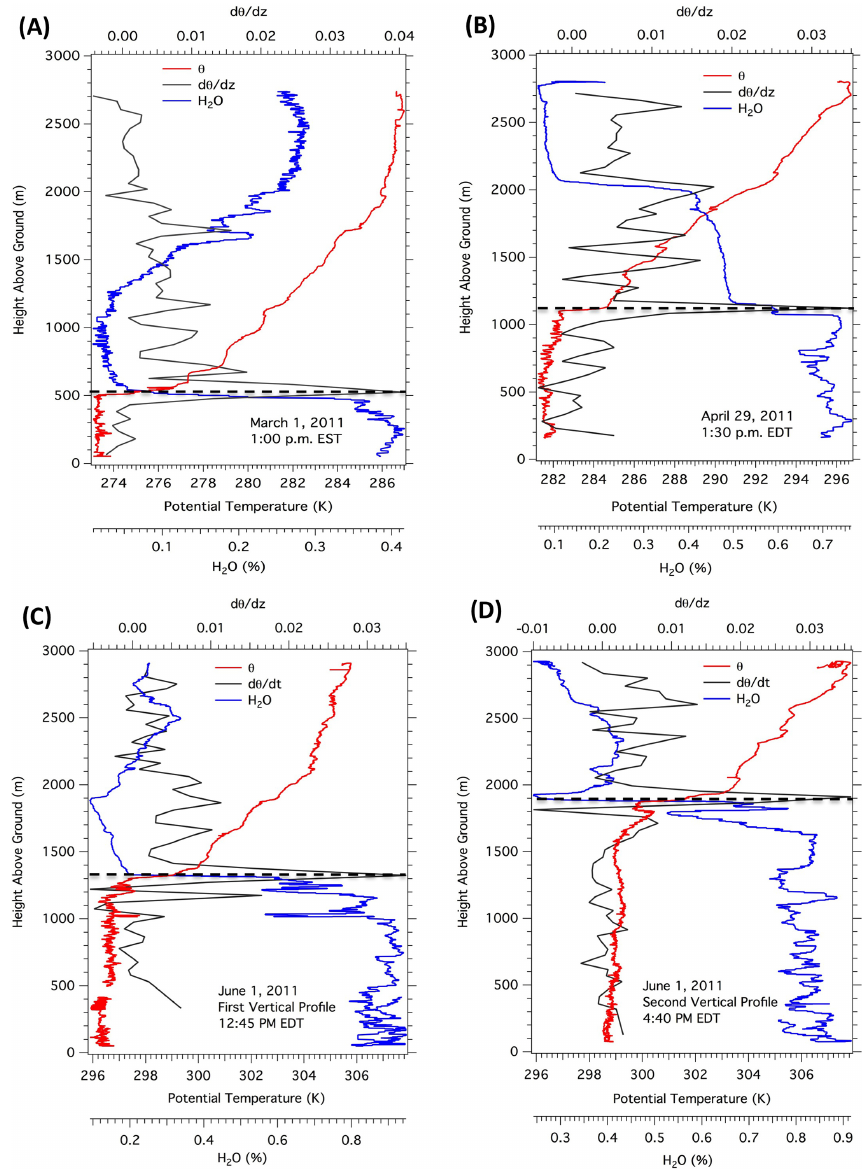
Figure 2. Vertical ascending profiles of H 2 O, potential temperature ( θ) , and its gradient with altitude (d θ /d z ) for (a) 1 March and (b) 29 April, and (c) 1 June 2011 before and (d) after the horizontal transects. Broken lines indicate the estimated CBL depths for the three flight